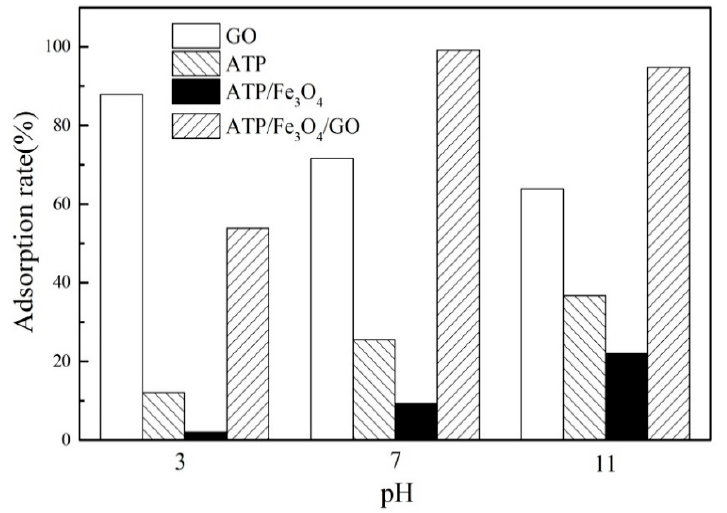
Figure 5. A comparison of the adsorption capacities of propranolol (PRO) onto GO, ATP, ATP/Fe 3 O 4 , and ATP/Fe 3 O 4 /GO.